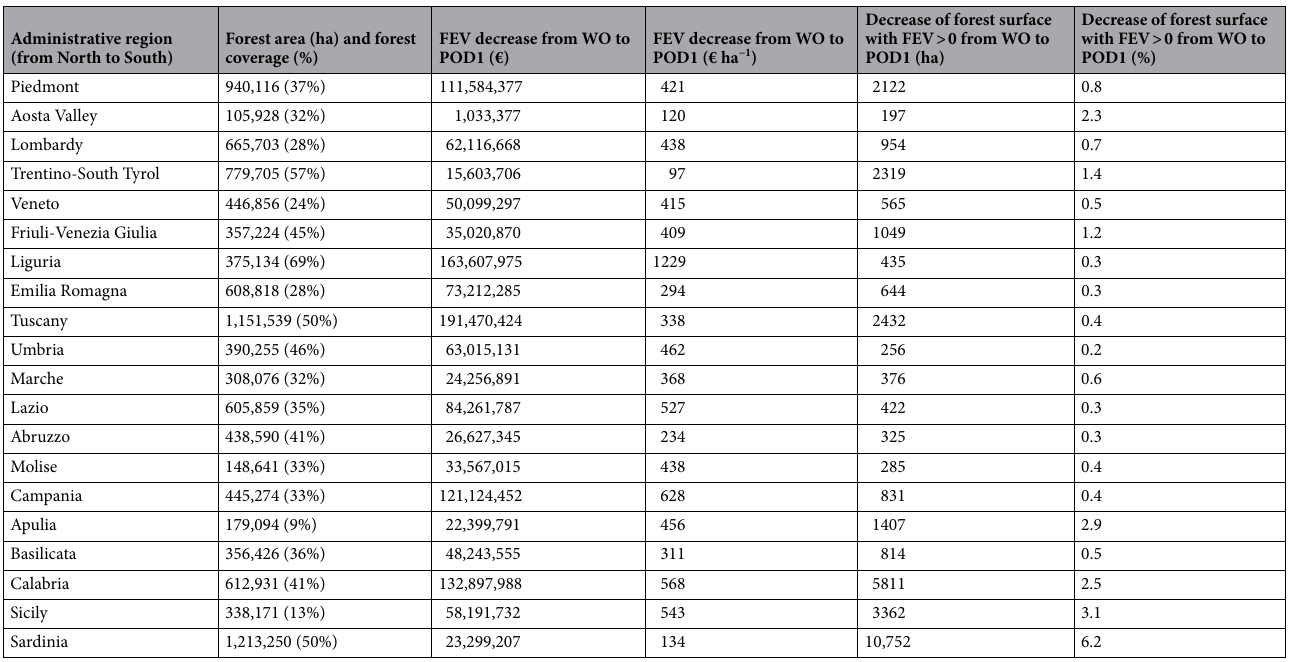
Table 4. Reduction of forest expectation value (FEV) and forest area from the WO to the POD1 scenario. Results are for Italian regions in 2005, with interest rate r =